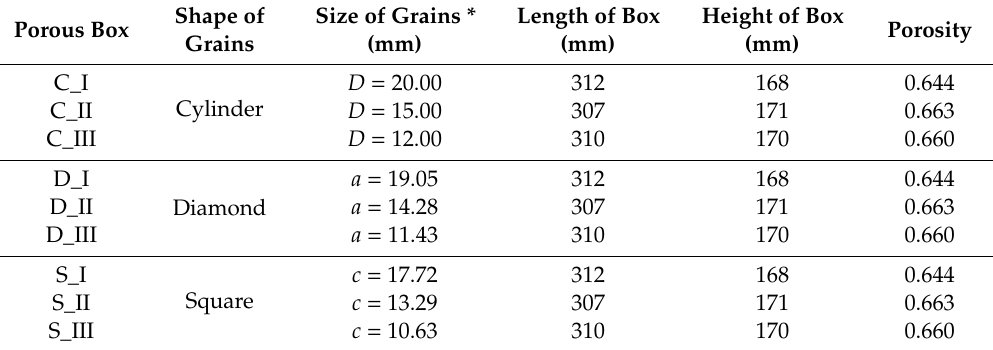
Figure 1. Porous boxes with different shaped grains. ( a ) Cylinder grains; ( b ) Diamond grains; ( c ) Square grains. Table 1. The parameters of the porous boxes.